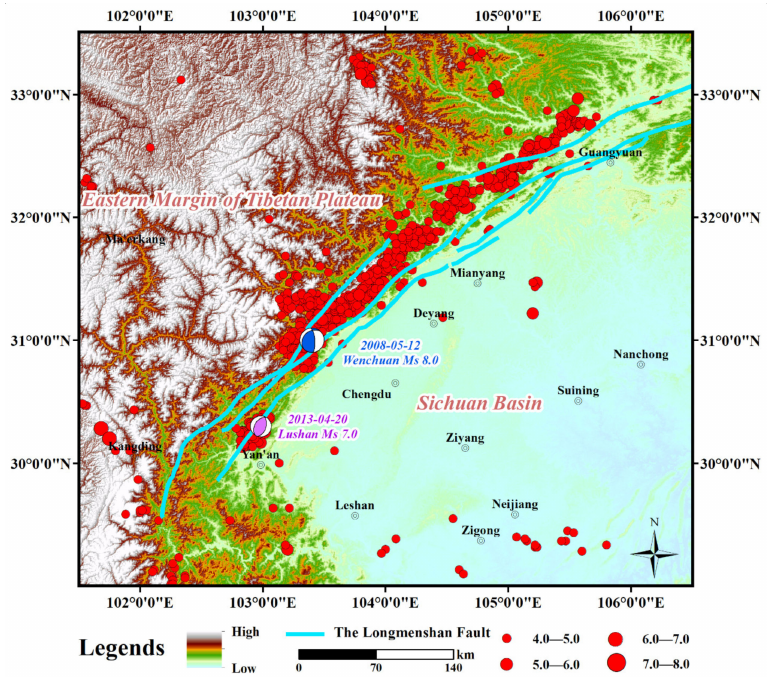
Figure 1. The topographic and tectonic map of the Longmenshan fault zone and its surrounding region. Blue beach ball represents the focal mechanism of the Wenchuan M S 8.0 earthquake. Pink beach ball represents the focal mechanism of the Lushan M S 7.0 earthquake. Red circles represent epicenters of earthquakes ( M S ≥ 4) from 1 January 2000 to 1 January